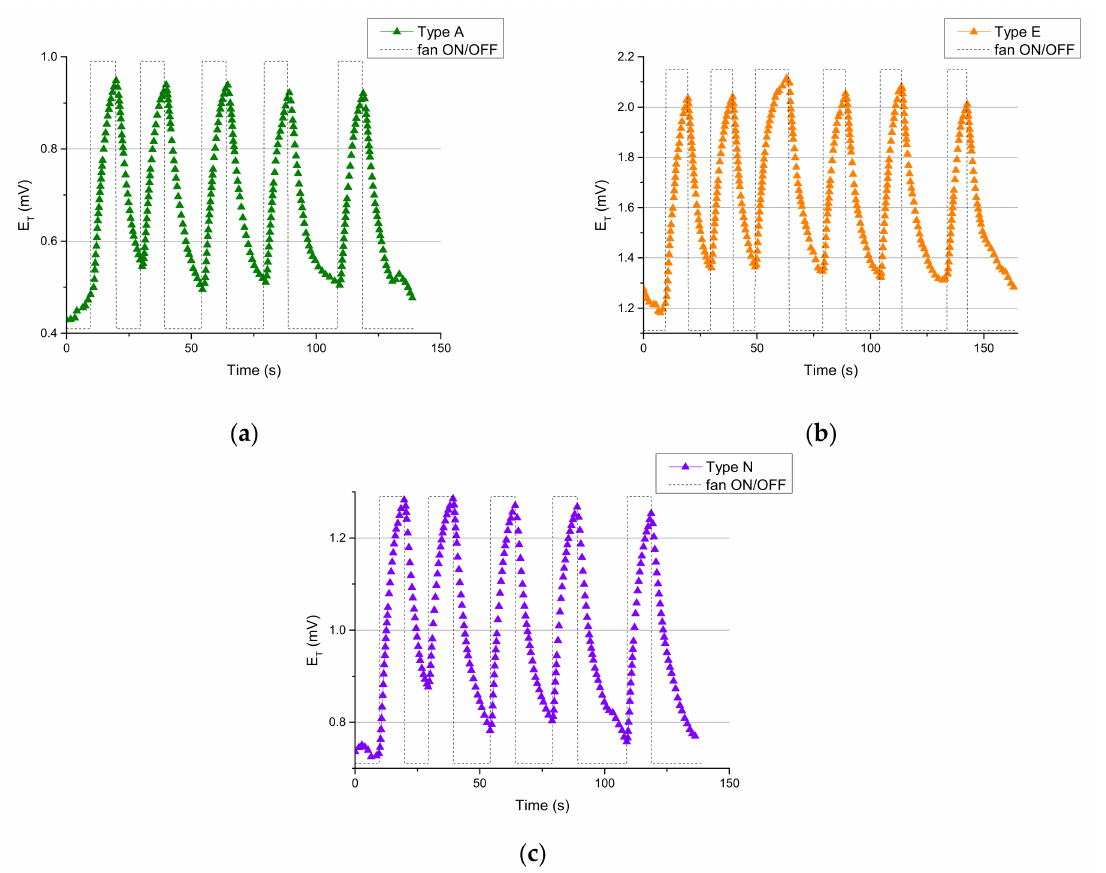
Figure 19. The voltage response of the sensors—measurements interval 0.209 s: ( a ) sensor version A; ( b ) sensor version E; ( c ) sensor version N. The black dotted line indicates the moments when the fan was switched on and